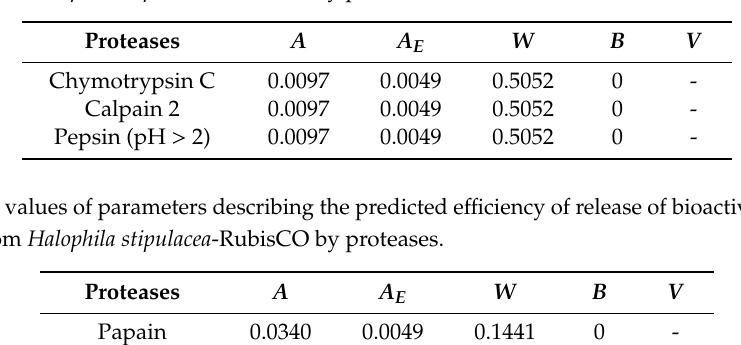
Table 7. The values of parameters describing the predicted e ffi ciency of release of bioactive antiamnestic fragment from Halophila stipulacea -RubisCO by proteases.